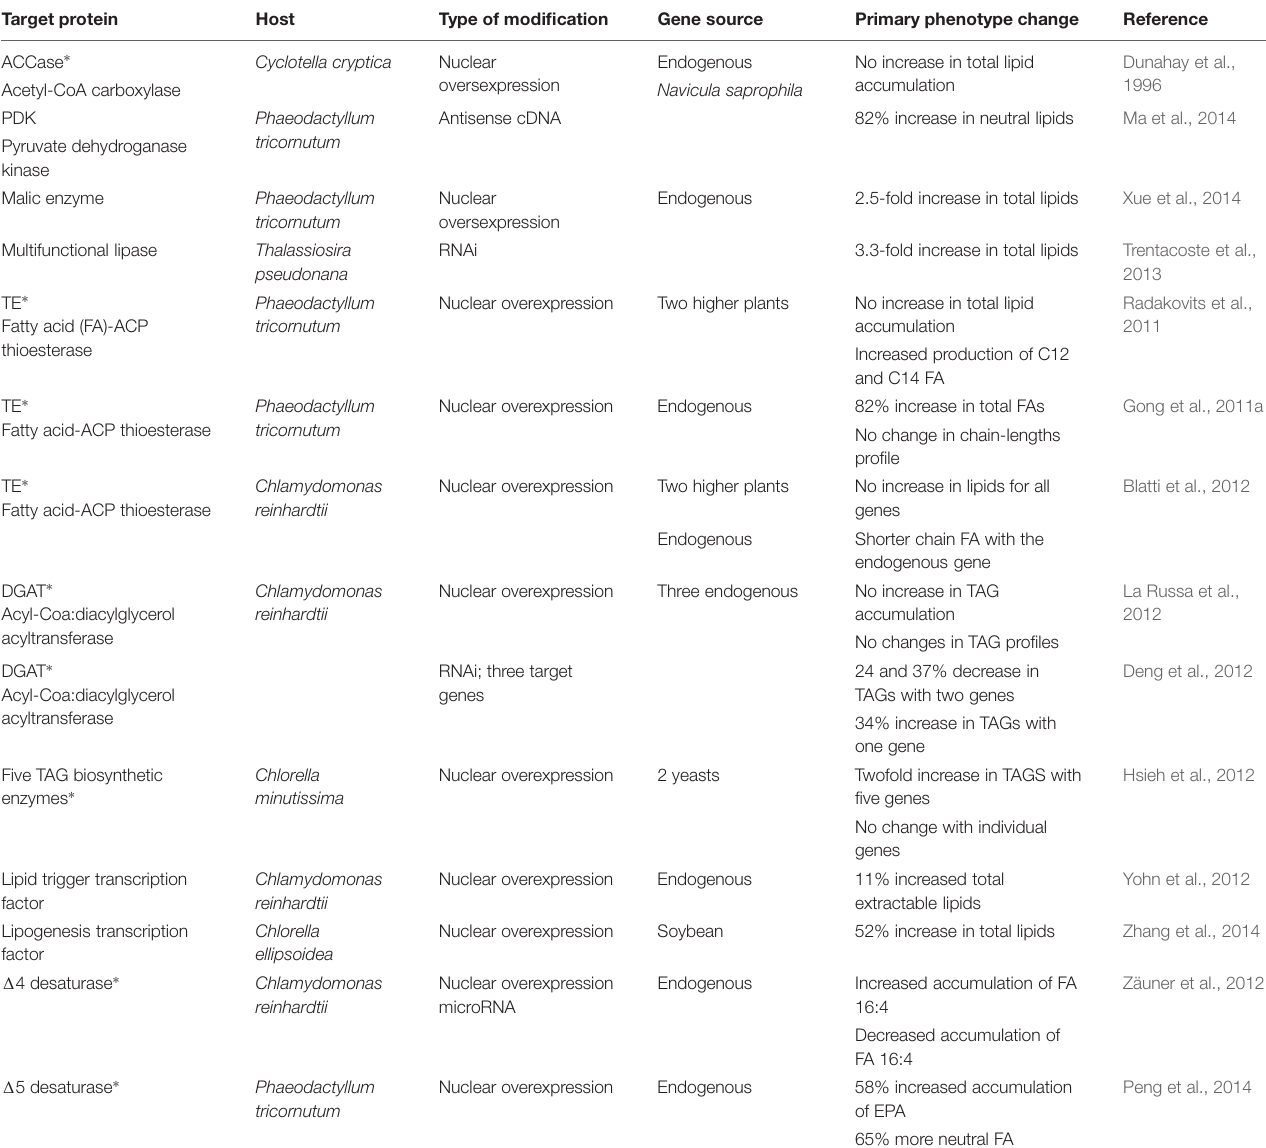
TABLE 1 | Metabolic engineering reports for lipid synthesis in